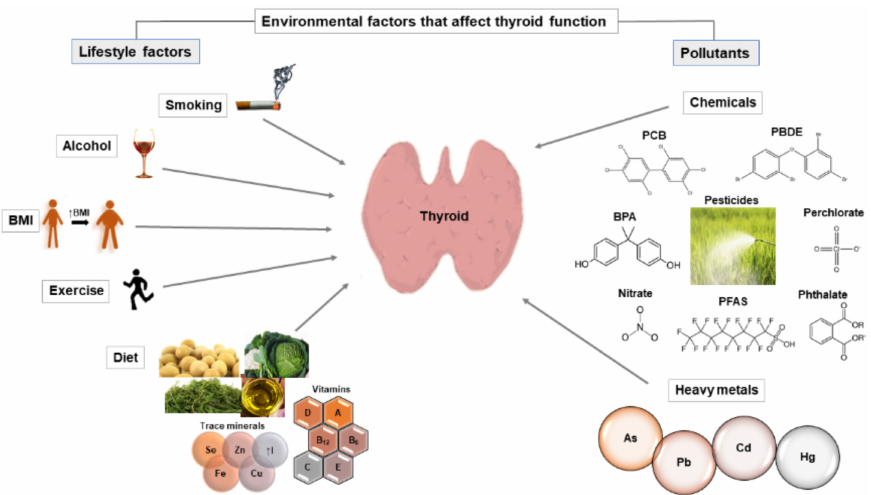
Figure 1. Environmental factors (lifestyle factors and pollutants) that affect thyroid function. As, ar- senic; BMI, body mass index; BPA, bisphenol A; Cd, cadmium; Cu, copper; Fe, iron; Hg, mercury; I, iodine; Pb, lead; PBDE, polybrominated diphenyl ether; PCB, polychlorinated biphenyl; PFAS, perfluoroalkyl substance; Se, selenium; Zn,